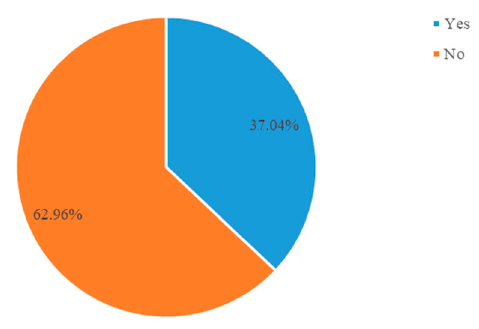
Figure 4. Percentage of Conservatories in which CICT exist.